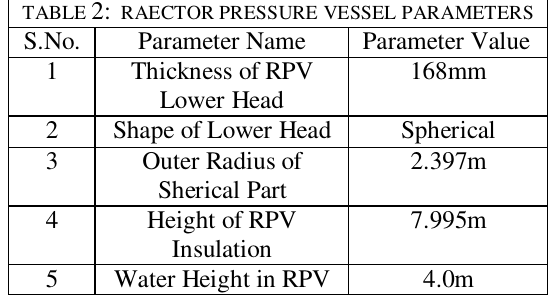
TABLE 2: RAECTOR PRESSURE VESSEL PARAMETERS S.No.